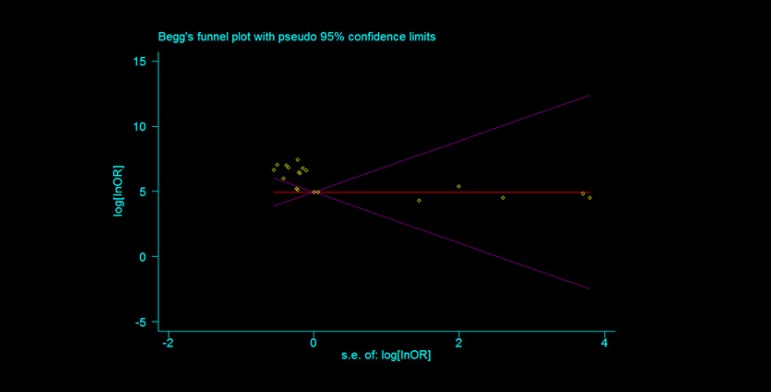
Begg's funnel plot.